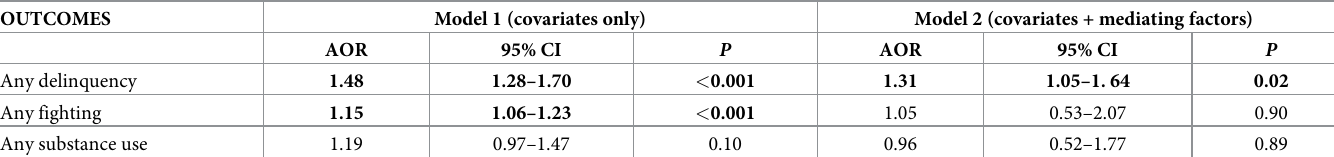
AOR = adjusted odds ratio; CI = confidence interval.